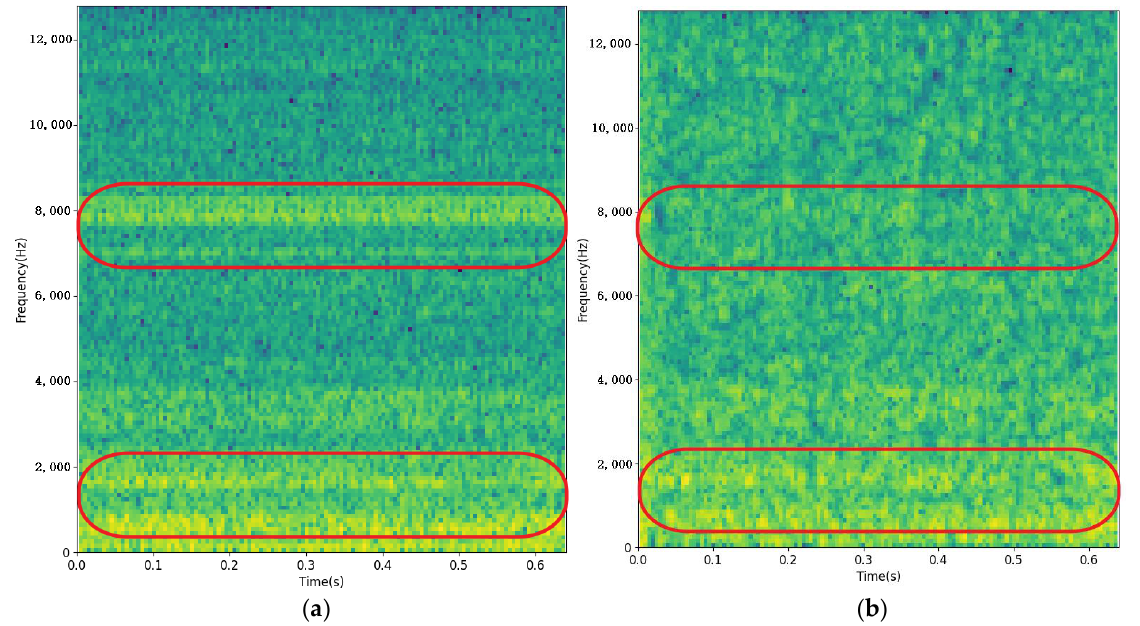
Figure 5. Time – frequency spectrum: ( a ) the first microphone signal; and ( b ) its de-reverberation signal.